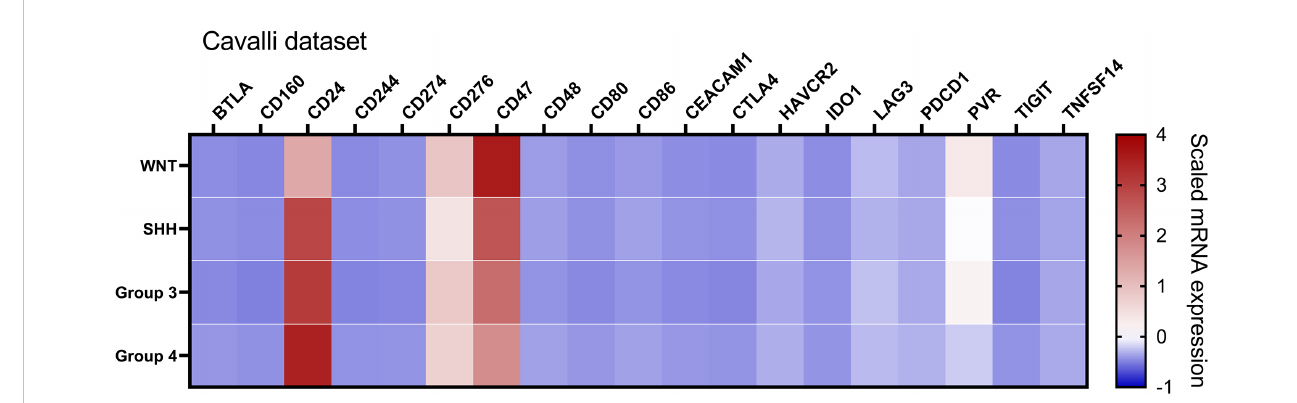
FIGURE 4 Heatmap of the mRNA levels of 19 immune checkpoint-related genes in the Cavalli et al. dataset. The color scale represents the scaled mRNA. The graph was obtained through GraphPad Prism